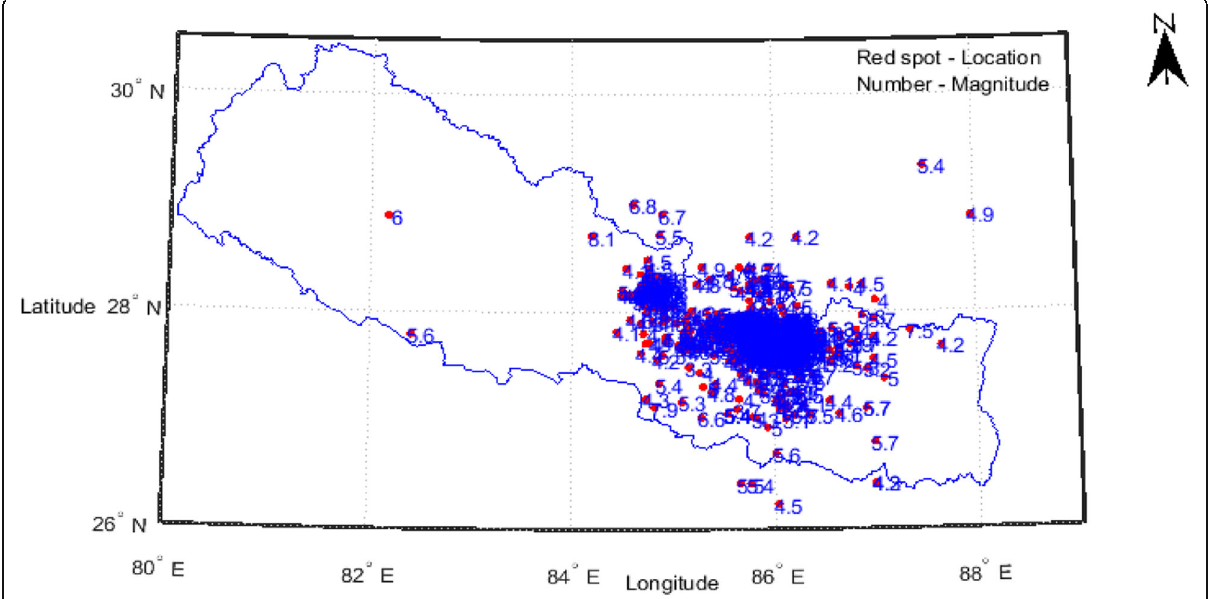
Fig. 2 Earthquake distribution map representing magnitude, location, latitude degree and longitude degree of Nepal earthquake